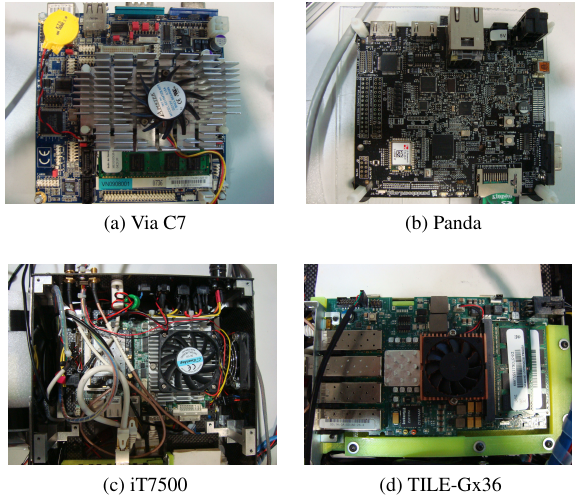
Figure 1: Boards/processors used in the